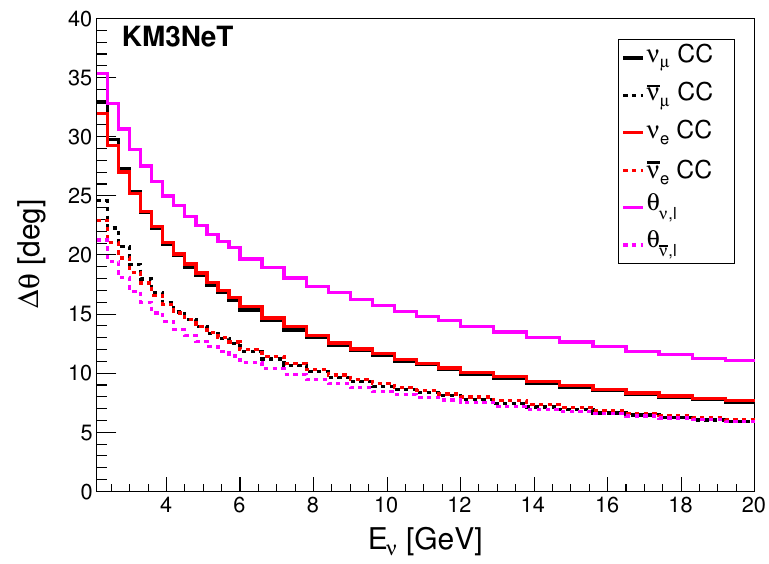
Figure 14 . Direction resolution (68% quantiles) for (cid:23) (cid:22) (black solid), (cid:23) (cid:22) (black dashed), (cid:23) e (red solid) and (cid:23) e CC events (red dashed). For comparison, the 68% quantiles of the scattering